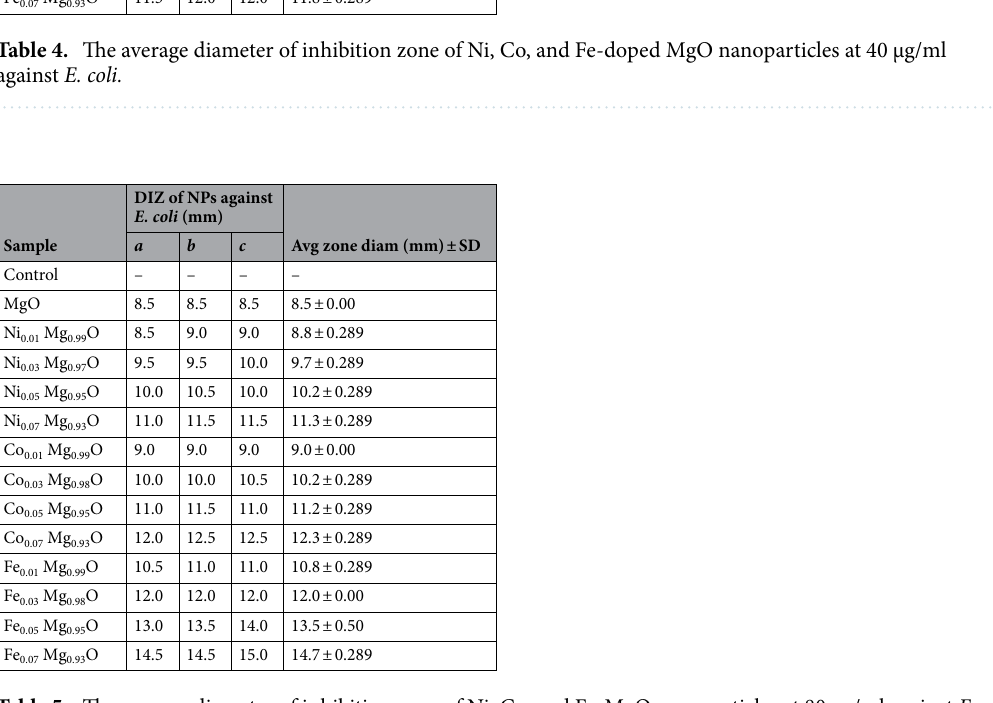
Table 5. The average diameter of inhibition zone of Ni, Co, and Fe-MgO nanoparticles at 80 μg/ml against E. coli .